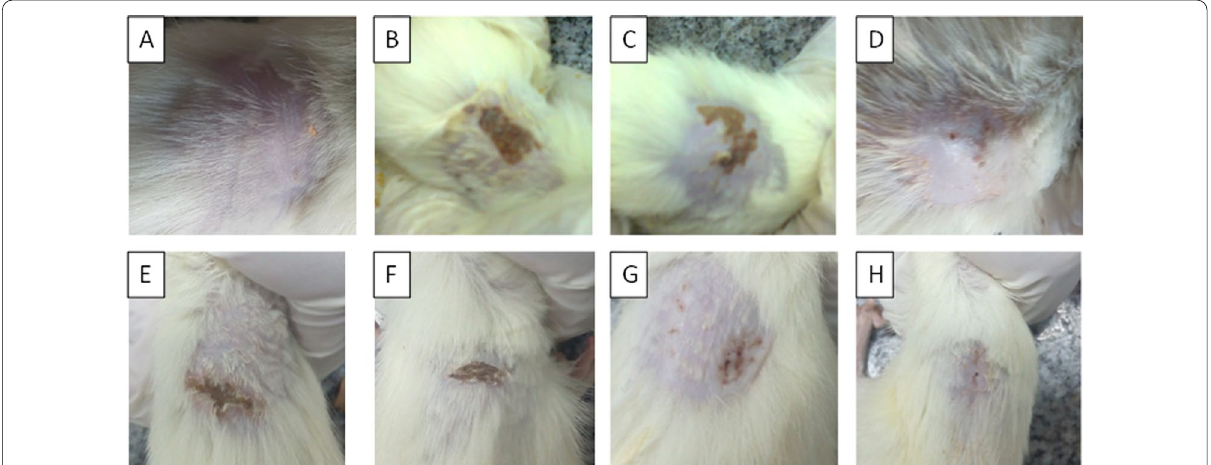
Fig. 2 Images of injured skin at 9th day of injury of a representative rat from: A control, intact, non‑infected, untreated; B control, injured, infected, untreated; C control, injured, infected, vehicle; D control, injured, non‑infected, untreated; E injured, infected, treated with Formula 1 (2% LRJ GE); F injured, infected, treated with Formula 2 (4% LRJ treated with Formula 4 (4% LRJ